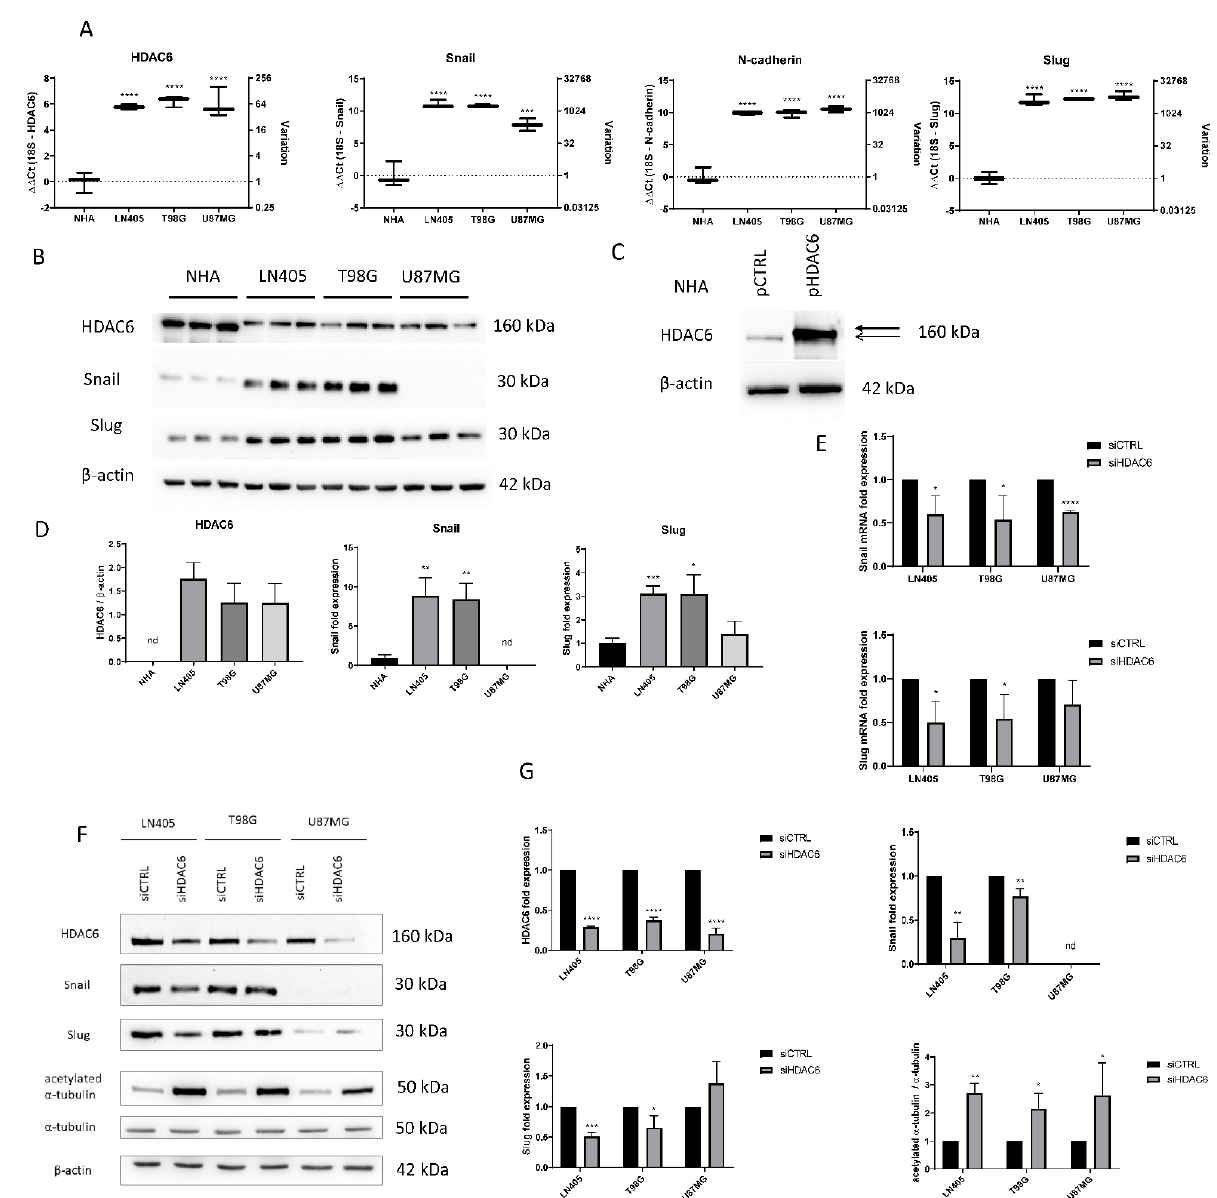
Figure 2. HDAC6 silencing decreases the overexpression of HDAC6 and mesenchymal markers in GBM cell lines. ( A ) Basal expression of mRNA levels of HDAC6, Snail, Slug, and N-cadherin in human GBM cell lines and NHA cell line. Data are represented as mean ± SD. (***) p < 0.001, (****) p < 0.0001 vs. NHA ( n = 3). ( B ) Representative western blot image for HDAC6, Snail, Slug, and β -actin of human GBM cell lines and NHA cell line. ( C ) Western blot image of HDAC6 in control NHA- and pHDAC6-transfected NHA cell line. Thick line shows real HDAC6 band, while thin line shows the unspecific band. ( D ) Analysis of western blot. Data are represented as mean ± SD. (*) p < 0.05, (**) p < 0.01, (***) p < 0.001 vs. NHA. ( n = 3). nd: not determined. ( E ) mRNA levels of Snail and Slug relativized to siCTRL after siRNAs treatment. (*) p < 0.05, (***) p < 0.001 vs. siCTRL condition. ( F ) Representative western blot image for HDAC6, Snail, Slug, acetylated α - tubulin, α - tubulin, and β -actin after treatment with siRNAs. ( G ) Analysis of western blot. Data are represented as mean ± SD. (*) p < 0.05, (**) p < 0.01, (***) p < 0.001, (****) p < 0.0001, vs. siCTRL condition ( n = 3). nd: not determined.